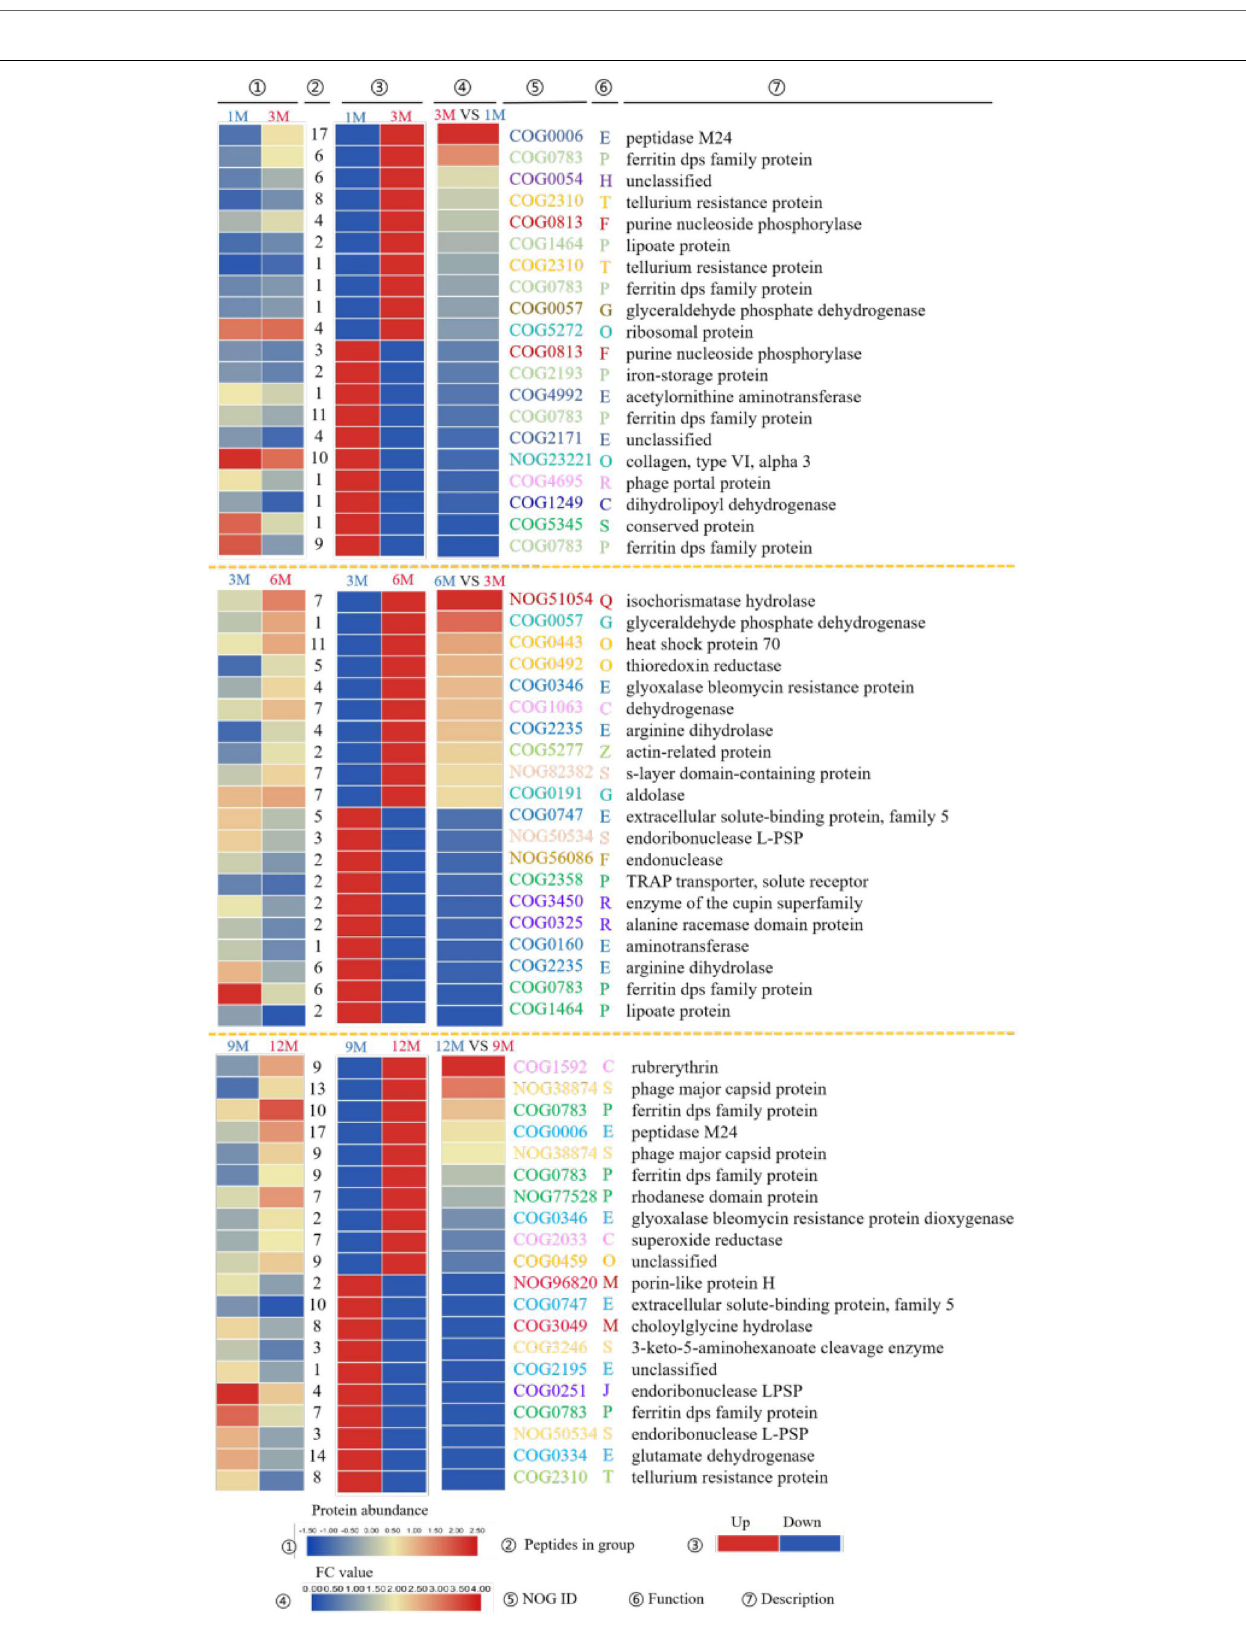
Frontiers in Nutrition |